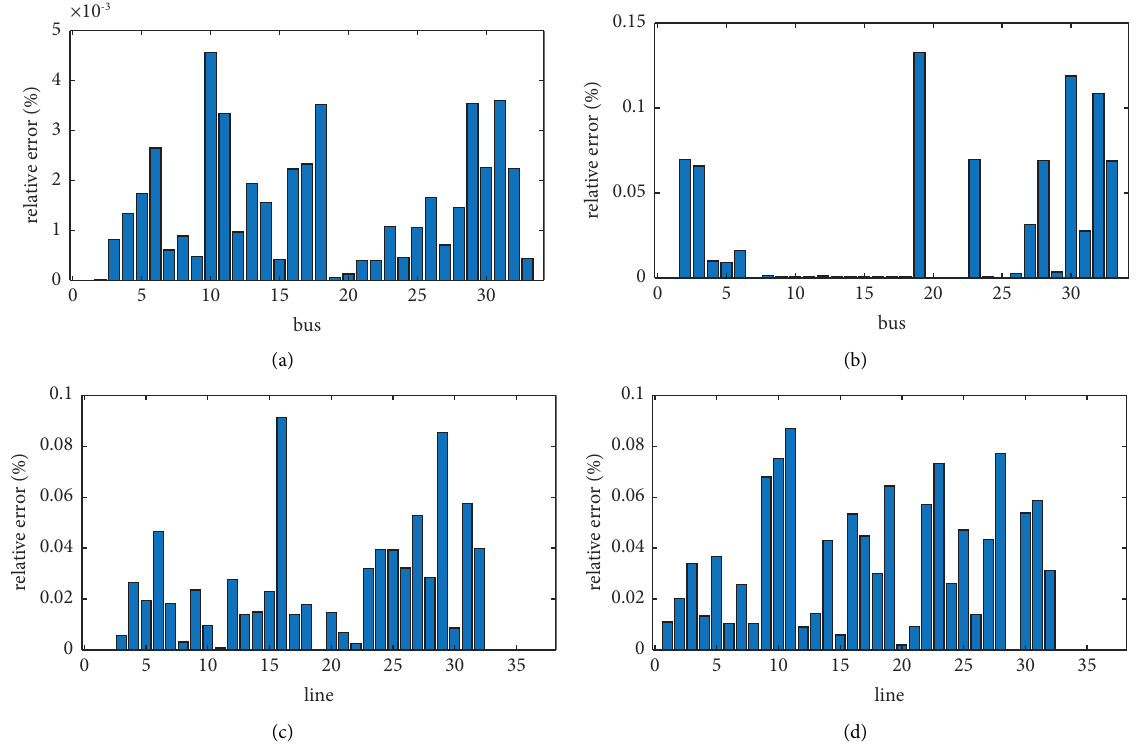
Figure 3: Relative errors of random fuzzy mean of two methods. (a) V